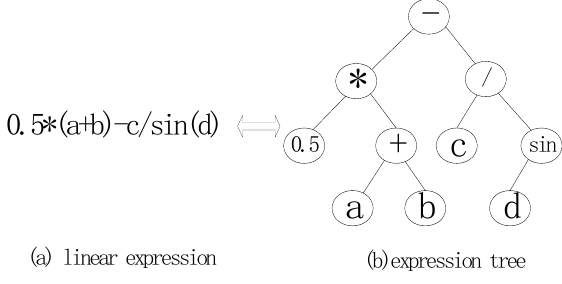
Fig. 3. Mapping relationship of linear expression and expression tree.